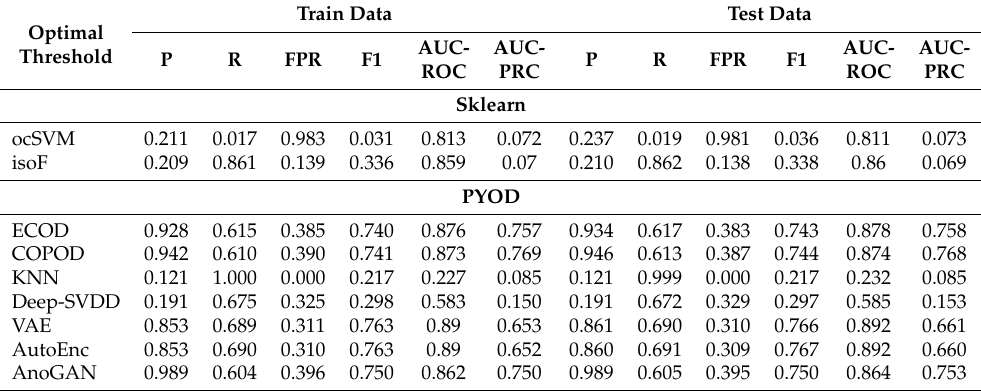
Table 5. The results of Experiment 1 for the random split mode for the SWaT dataset.